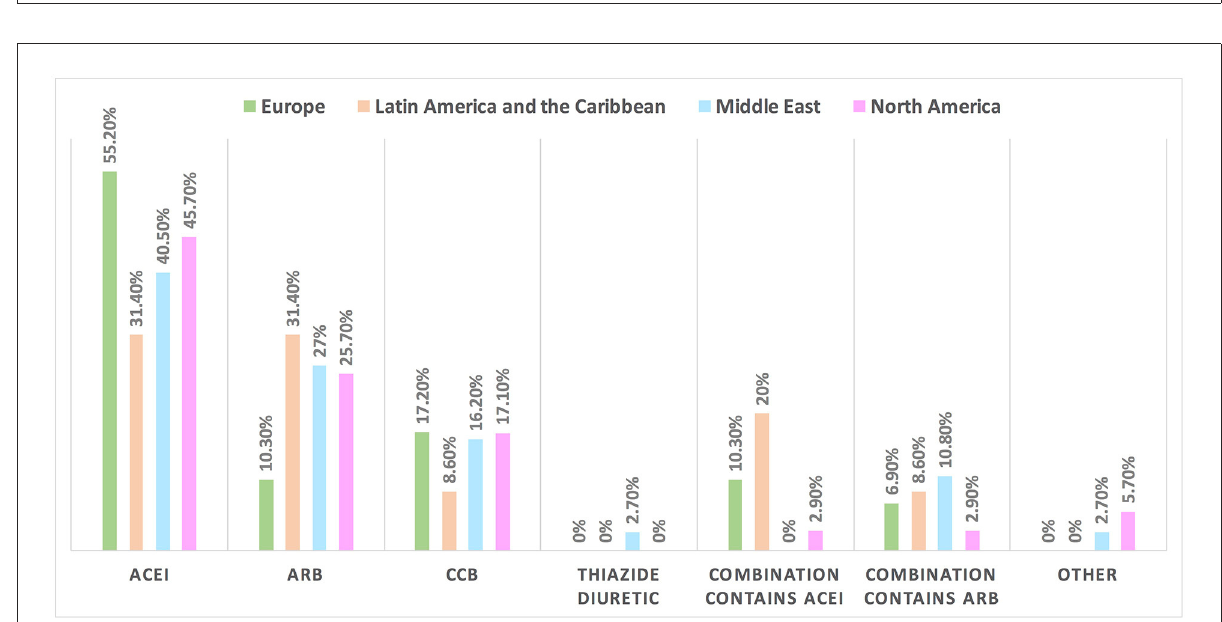
FIGURE5 The most common treatment for hypertension induced by cancer therapies among patients with cancer in different continents. ACEI is the most commonly used drug for the management of hypertension induced by cancer therapy; however, compared with the rate of drugs used in the management of hypertension not induced by cancer therapy (in Figure 4), the rate of utilization of CCB and combination therapy increased particularly for the use of combination treatment containing ACEI in Latin America and the Caribbean. ACEI, angiotensin-converting enzyme inhibitor; ARB, angiotensin receptor blocker; CCB, calcium channel blocker.